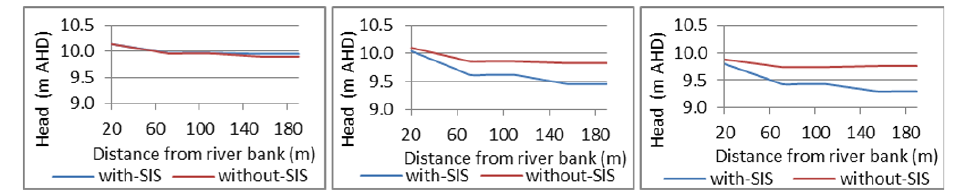
Fig. 12. Groundwater head longitudinal profiles on 7 March 2007 (left), 16 November 2008 (middle) and 29 July 2009 (right) on transect B2 for the with-SIS and the without-SIS scenarios.